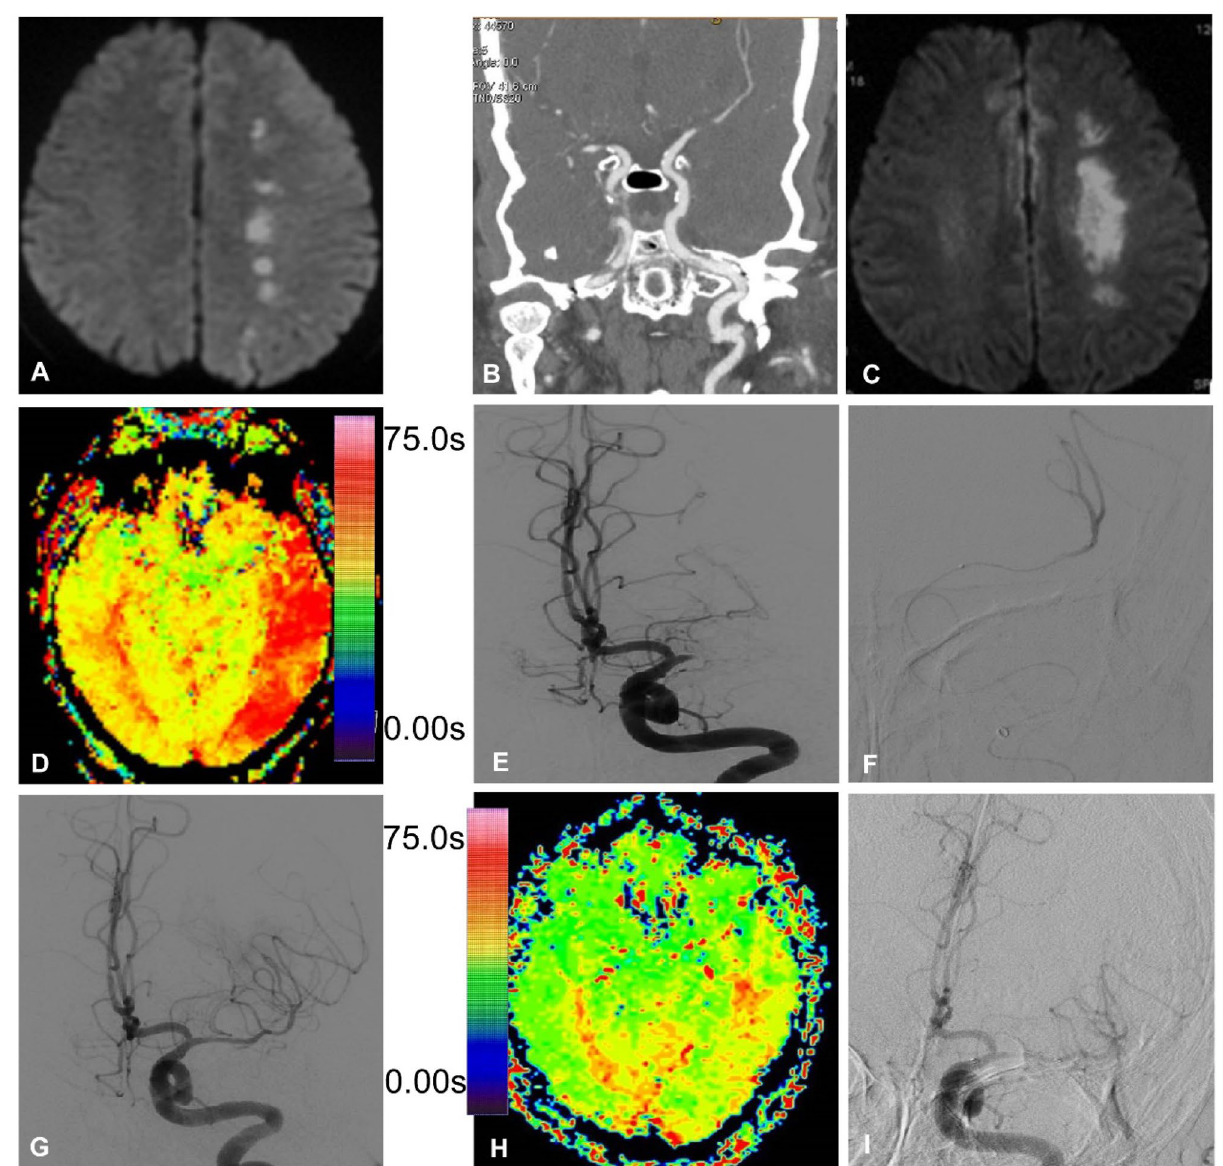
Figure 4. Endovascular recanalization of occluded left middle cerebral artery (MCA) and angiographic follow-up. ( A ) DWI of magnetic resonance imaging (MRI) immediately after admission revealed bead-like high signal in the left hemisphere. ( B ) Computed tomography angiography showed occluded M1 segment of the left MCA. ( C ) Two days after admission, DWI of MRI demonstrated increased area of high signal lesions in the left hemisphere with fusion of the original bead-like lesions. ( D ) PWI of MRI revealed greater time needed for the blood flow to reach the left hemisphere. ( E ) Digital subtraction angiography showed occluded M1 segment of the left MCA with no display of the distal arterial branches. ( F ) A microguidewire was used to explored the occluded M1 segment, and a microcatheter was navigated along the microguidewire through the occluded M1 segment into the M2 segment of the left MCA, and angiography through this microcatheter indicated patency of distal arterial branches. ( G ) An Enterprise 4.5 mm*22 mm stent was deployed at the occluded segment after balloon angioplasty, with recanalized arterial branches of the left MCA. ( H ) PWI of MRI demonstrated improved blood flow to the left hemisphere, much better than before recanalization. ( I ) Digital subtraction angiography six months later revealed patent left MCA with no instent